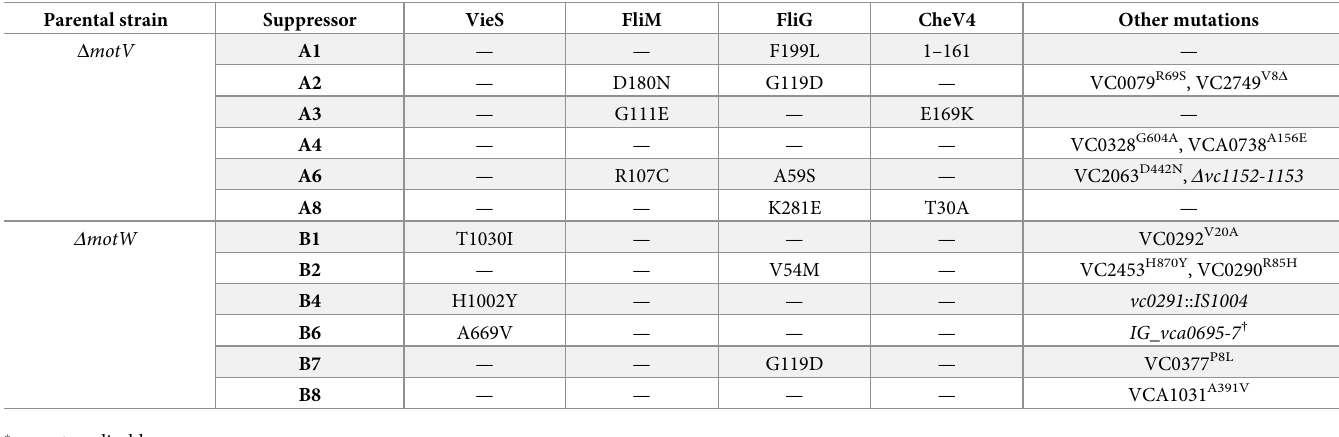
Table 1. Summary of generated strains with suppressor mutations � . Parental